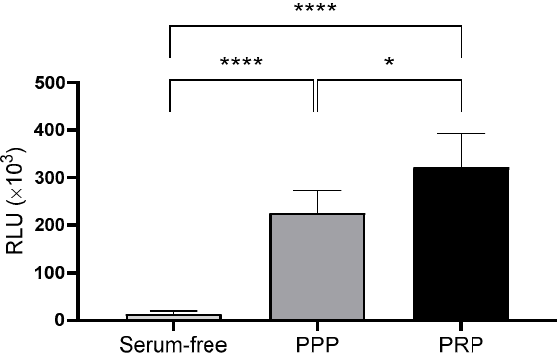
Figure 2. Viability of dermal fibroblasts cultured using a medium supplemented with either platelet-poor plasma (PPP) or platelet-rich plasma (PRP). Viability was measured by luminescence as relative light unit (RLU) after 96 h incubation under each condition. Serum-free medium was used as the negative control. The statistical significance of the differences in viability levels between serum-free control and PPP and PRP supplementation was determined by ANOVA test (* p < 0.05; **** p < 0.0001) ( n = 5).